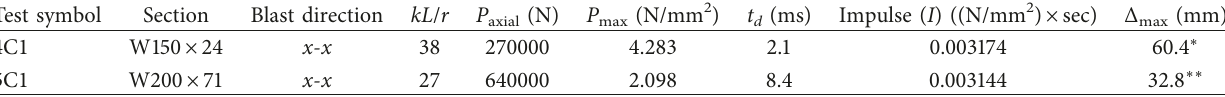
Table 1: Geometrical properties, loading conditions, and test results of the steel columns used in the validations [4]. Test symbol Section